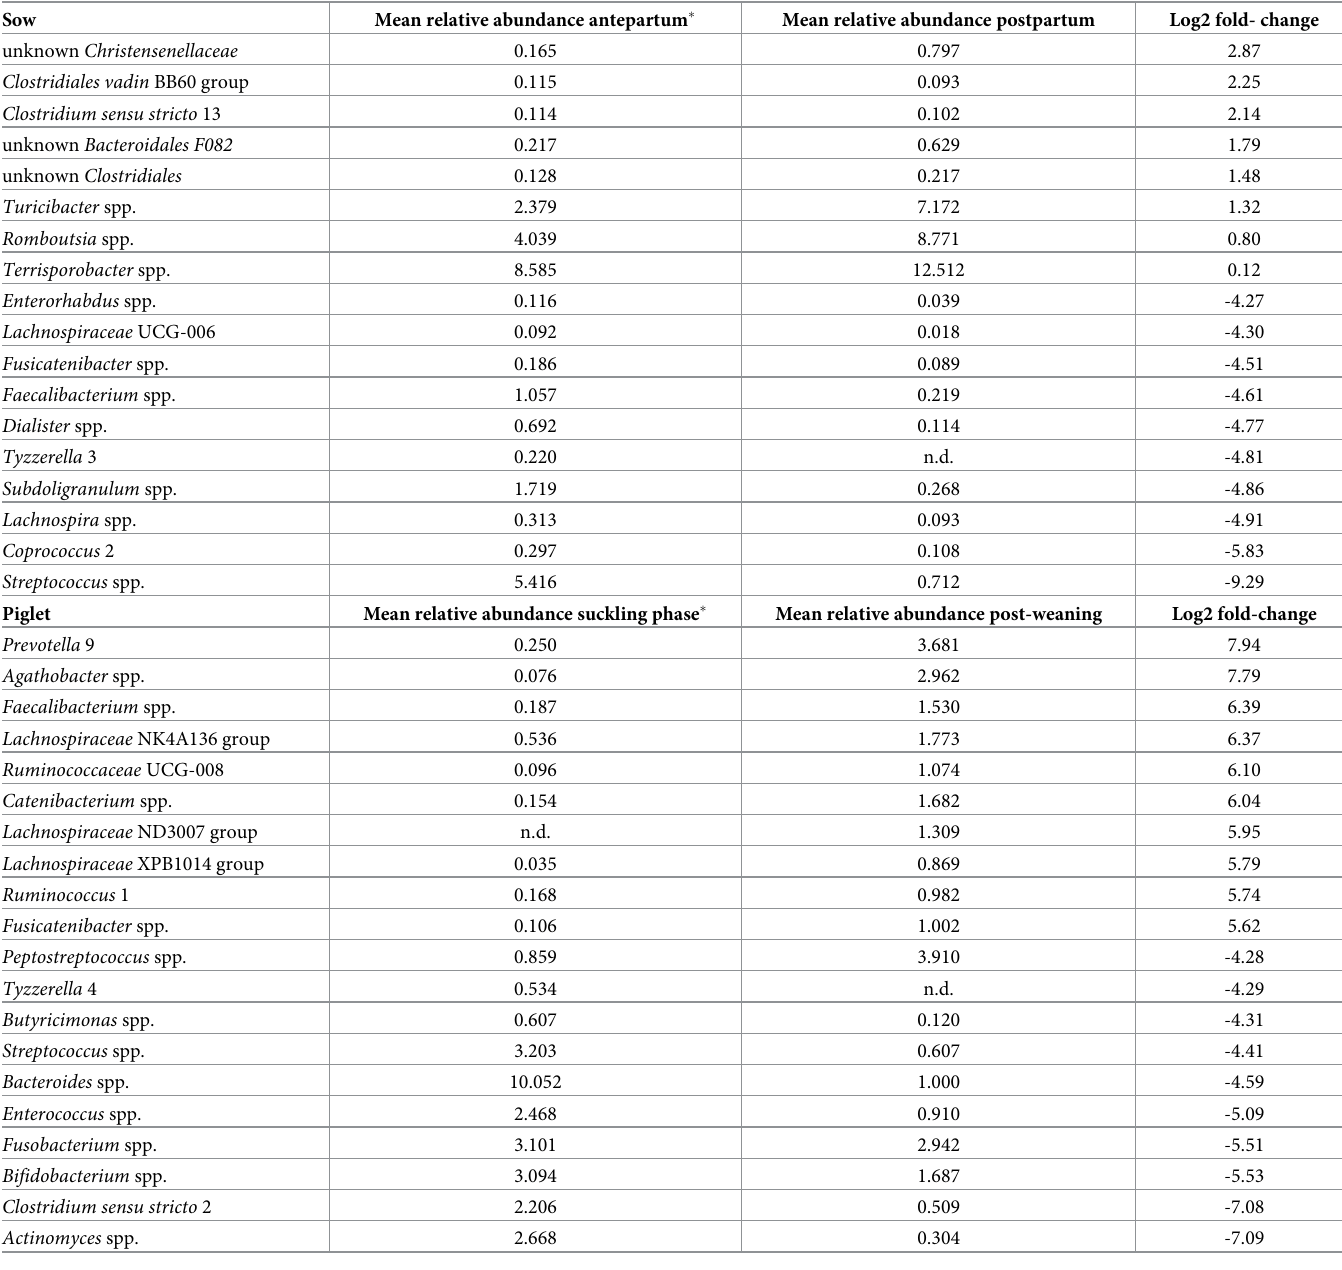
Table 1. Log2 fold-change of bacterial genera in ante- and postpartum sows as well as suckling and post-weaning piglets.